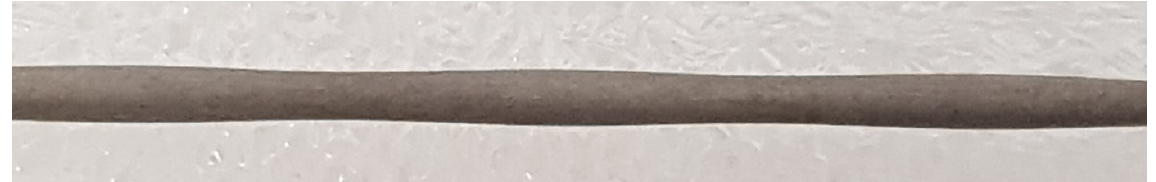
Figure 6. Macroscopic multi-neck effect observed for the sand casting of AZ91 (MgAl9Zn1) magnesium alloy extruded by the KOBO method with the processing degree of λ = 44.4 and the die rotation frequency f = 6 Hz stretched at 300 °C with the speed ε = 10 − 4 s − 1 .